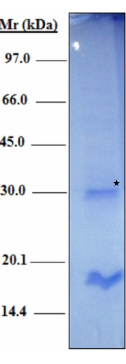
Figure 1. Size distribution of PLA-NPs using DLS technique. NPs were prepared by a nanoprecip- itation process in one single step without using surfactant.